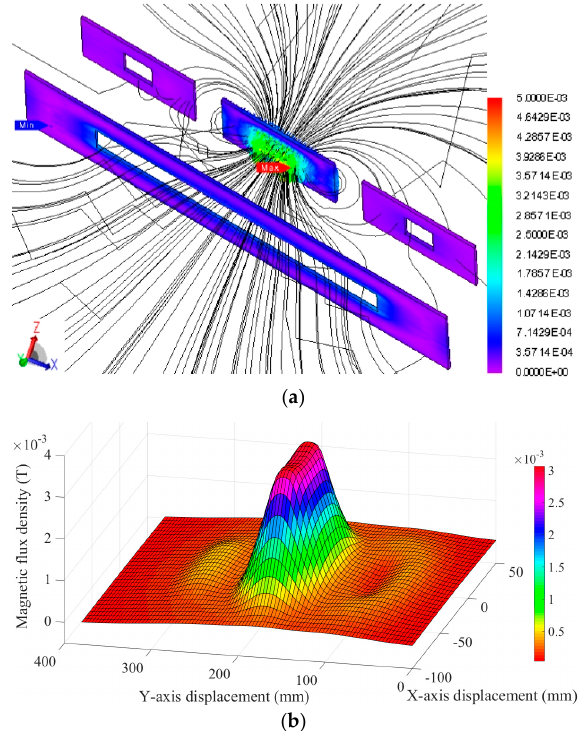
Figure 4. Electromagnetic field analysis at resonant frequency of 100 kHz: ( a ) magnetic flux line distribution; and ( b ) magnetic flux density